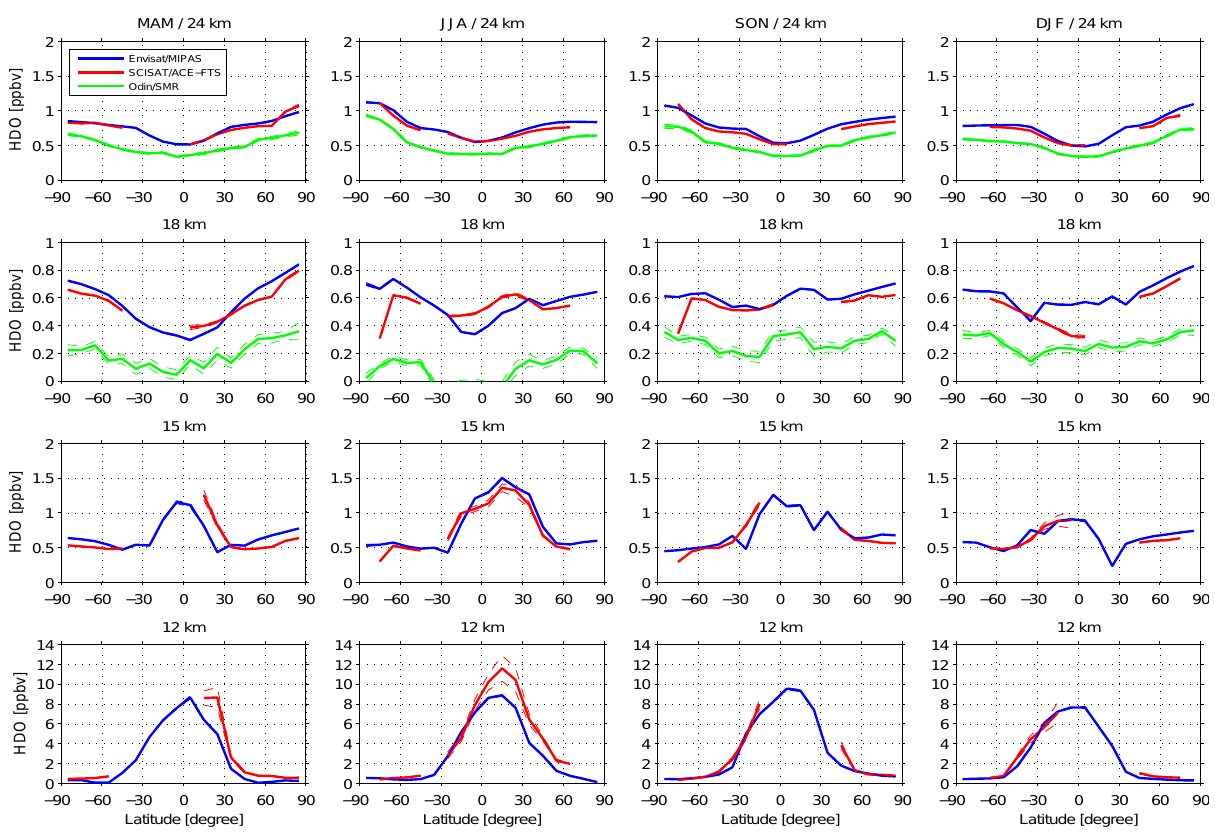
Fig. 3. Latitudinal cross sections of HDO from MIPAS (blue), SMR (green) and ACE-FTS (red) observations for different seasons and altitudes from 12km to 24km. The data were averaged over latitude bins of 10 ◦ . The MIPAS and SMR cross sections are based on observations from June 2002 to February 2004, for ACE-FTS the time periods June 2004–February 2006 and June 2006–February 2008 were used. Dashed lines indicate the standard error of the derived cross sections. Please note that the y-axis range changes with